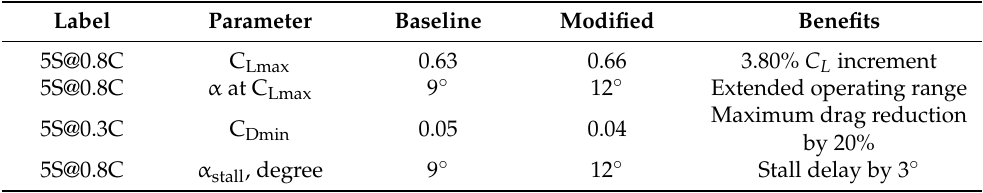
Figure 21. Comparison of aerodynamic efficiency (L/D) over baseline and modified wing with RVG, 5S, 5M, and 5L vortex generators. Table 3. Optimum aerodynamic configurations of SSVG operating at Re = 2.0 × 10 5